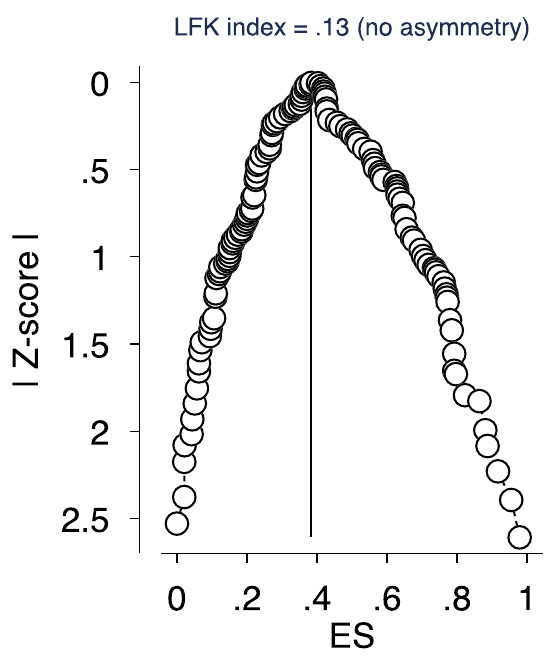
Figure 3. DOI plot and the Luis Furuya–Kanamori (LFK) index. Figure legend: depiction of publication bias in the baseline meta-analysis of proportion studies based on a DOI plot and the Luis Furuya – Kanamori (LFK) index — a score that is within ±1 indicates no asymmetry.